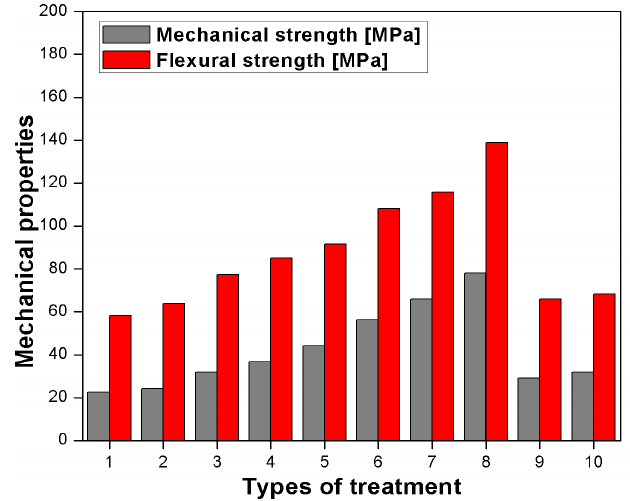
Figure 11. Mechanical properties of (1: Neat polyester; and different concentration of chemical treatment 2: untreated Sisal fibre; 3: 5% NaOH-treated; 4: 5% NaOH boiled; 5: 5% NaOH-treated; 6: 10% NaOH boiled; 7: 18% NaOH-treated; 8: 18% NaOH boiled; 9: 20% acetic acid-treated 10: methanol-treated) sisal/polyester composite.